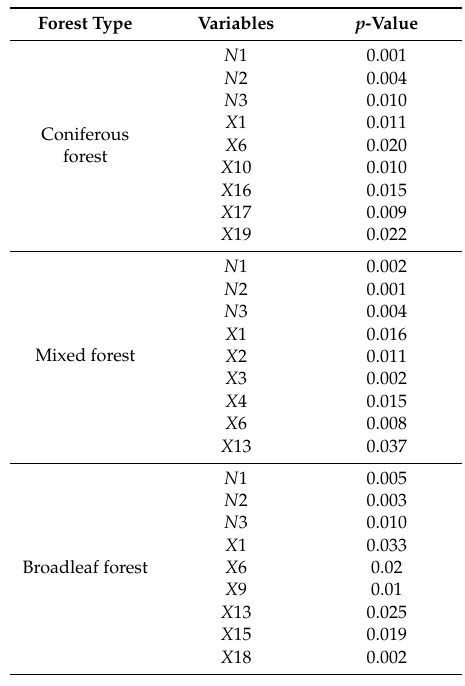
Table 4. P values of the coe ffi cients of models for di ff erent forest